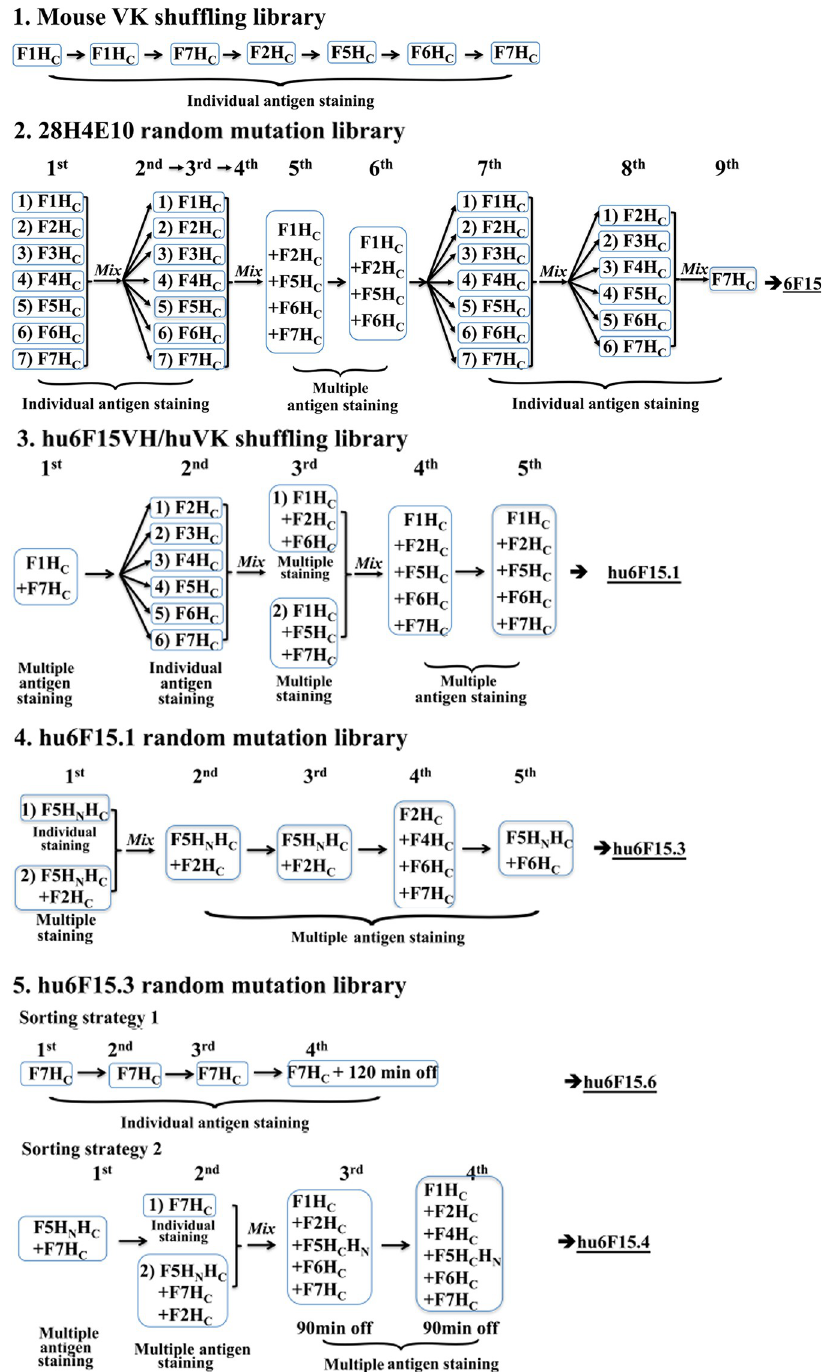
Fig 2. The detailed sorting strategies of each library. Each library was sorted using FACS at least four rounds using various strategies. Based on the different binding profile of the parental mAbs, libraries were stained with different strategies, including sequentially changed BoNT/F subtype, multiple BoNT/F subtype co-staining (multicolor FACS), or wild type mAb competence (off rate screen). The colonies from last round of sorting were plated on SD-CAA plates for further characterization including DNA sequence analysis and K D and k off measurements. The labels 1 st – 9 th indicate the round of staining and sorting. Details of staining and sorting conditions are provided in the methods. Library 1. Light chain shuffling of murine scFv 28H4. The library was stained with the indicated individual BoNT/F subtype and sorted for six rounds. This cycle of molecular evolution yielded the scFv 28H4E10. Library 2.